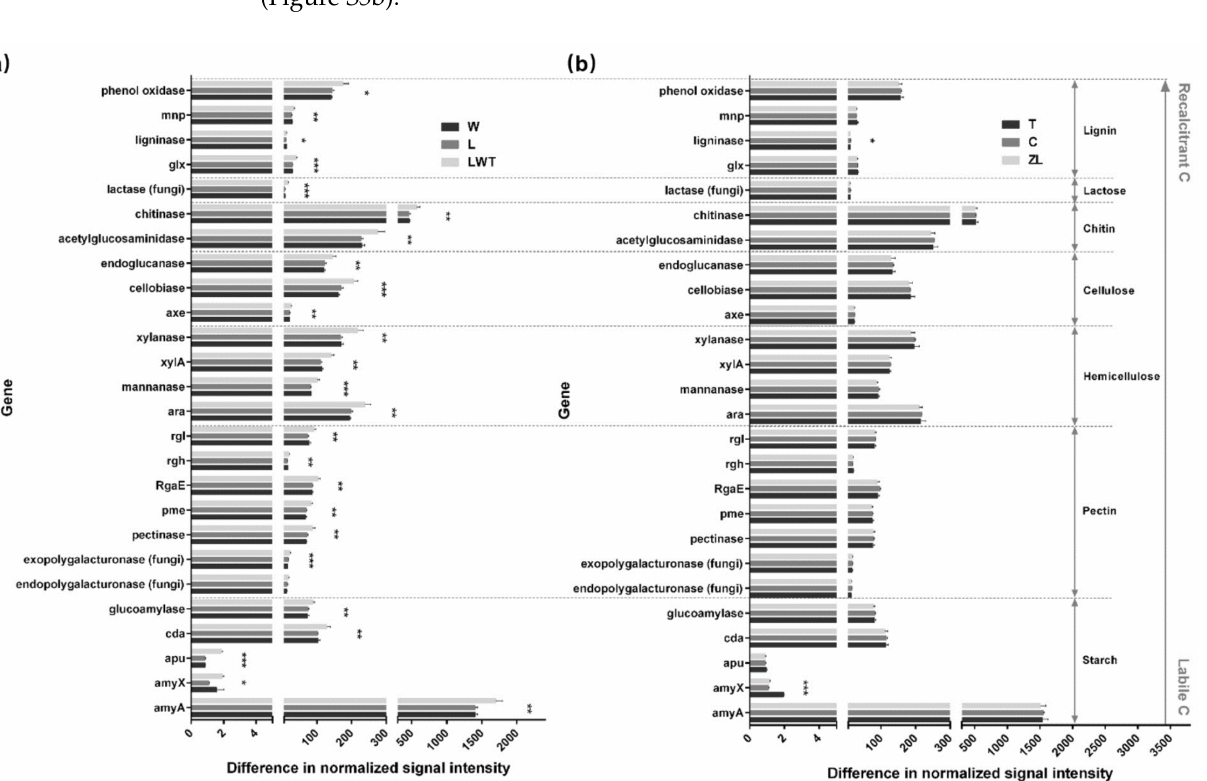
Figure 11. Normalized GeoChip signal intensities of genes involved in C decomposition in the restored (W), lightly degraded (L), and severely degraded (LWT) Phragmites marsh sites ( a ), and the natural (T, ZL) and degraded (C) Carex marsh sites ( b ), respectively. Error bars represent one standard deviation of the mean ( n = 3). ***, p < 0.001, **, p < 0.01, *, p < 0.05, based on the unpaired t -test. The complexity of carbon is ordered from labile to